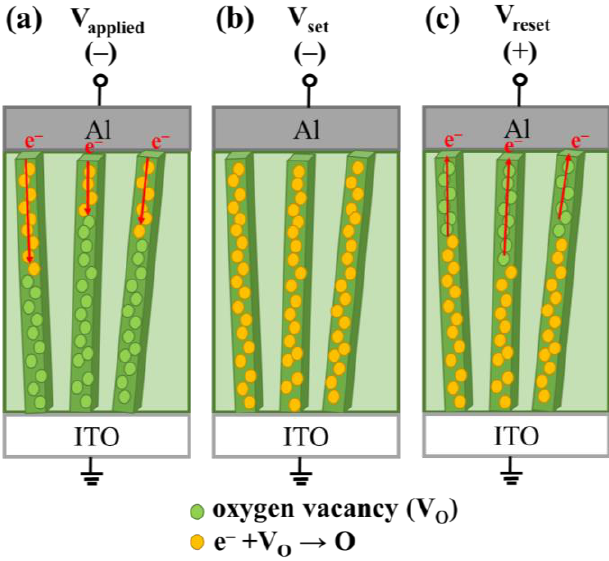
Figure 11. Schematic of the mechanisms of MZN NRs in terms of: ( a ) distribution of oxygen vacancies